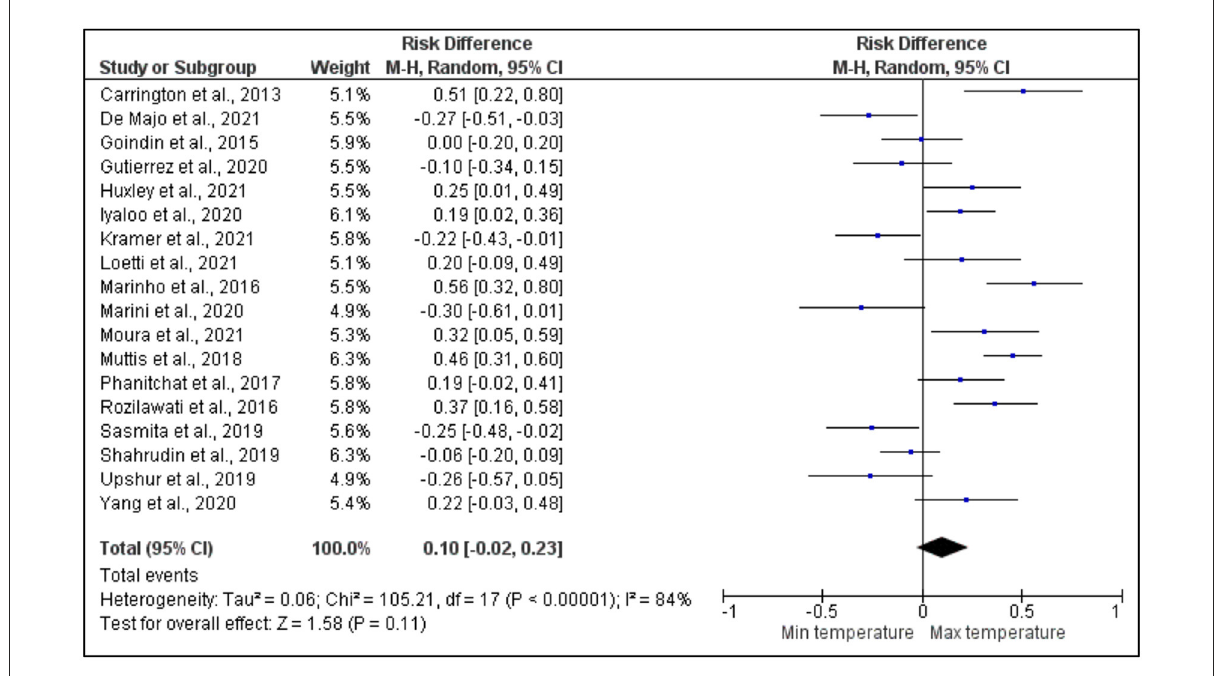
FIGURE5 Forest plot of comparison of the effect of minimum temperature vs. maximum temperature on the longevity of Aedes